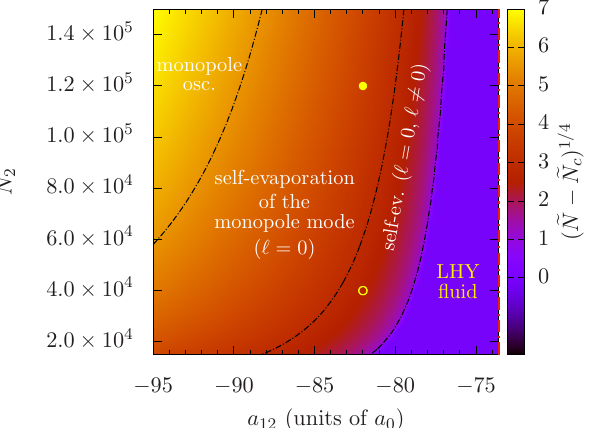
N N c ) 1/4 as a function of a 12 and N 2 , with N c = 18.65 being the critical Figure 1. Heat map of ( − N = 933.7, value for the existence of a droplet [1]. The dotted-dashed lines, corresponding to (cid:101) (cid:101) (cid:101) 94.2, 18.65 (from left to right), represent the boundaries between the different regimes (see text). (cid:101) The vertical red dashed-dotted line at a 12 = 73.6 corresponds to the onset of the MF collapse. The − two circles at a 12 = 82 a 0 refer to the parameter configurations considered in Section −